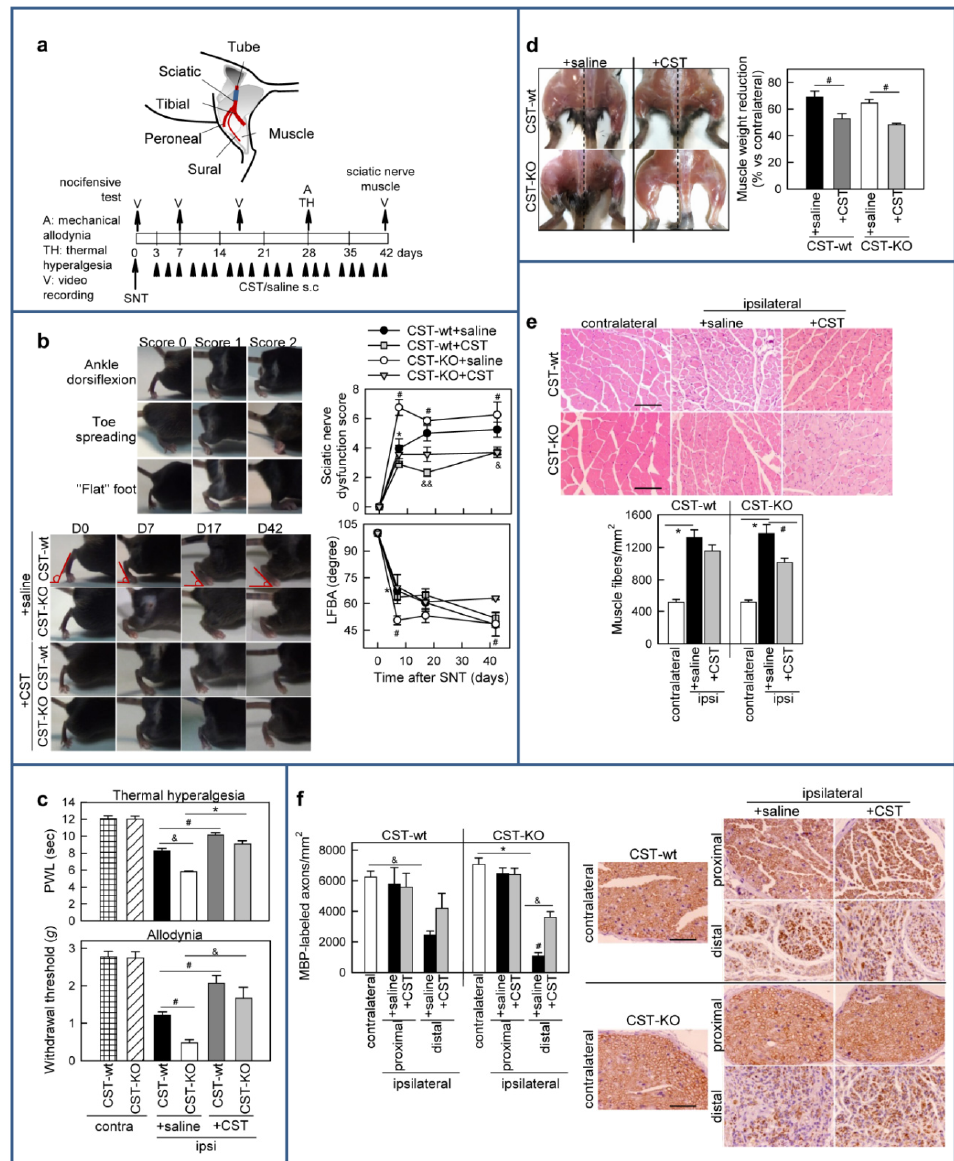
Figure 8. Cortistatin enhances functional recovery and sciatic nerve remyelination after severe nerve transection. ( a ) Schematic representation for the experimental design in the sciatic nerve transection (SNT) model. ( b ) Effects of cortistatin deficiency (CST-KO vs. CST-wt) and of local (s.c. 3 µg) cortistatin administration (every other day, for six weeks, as indi-